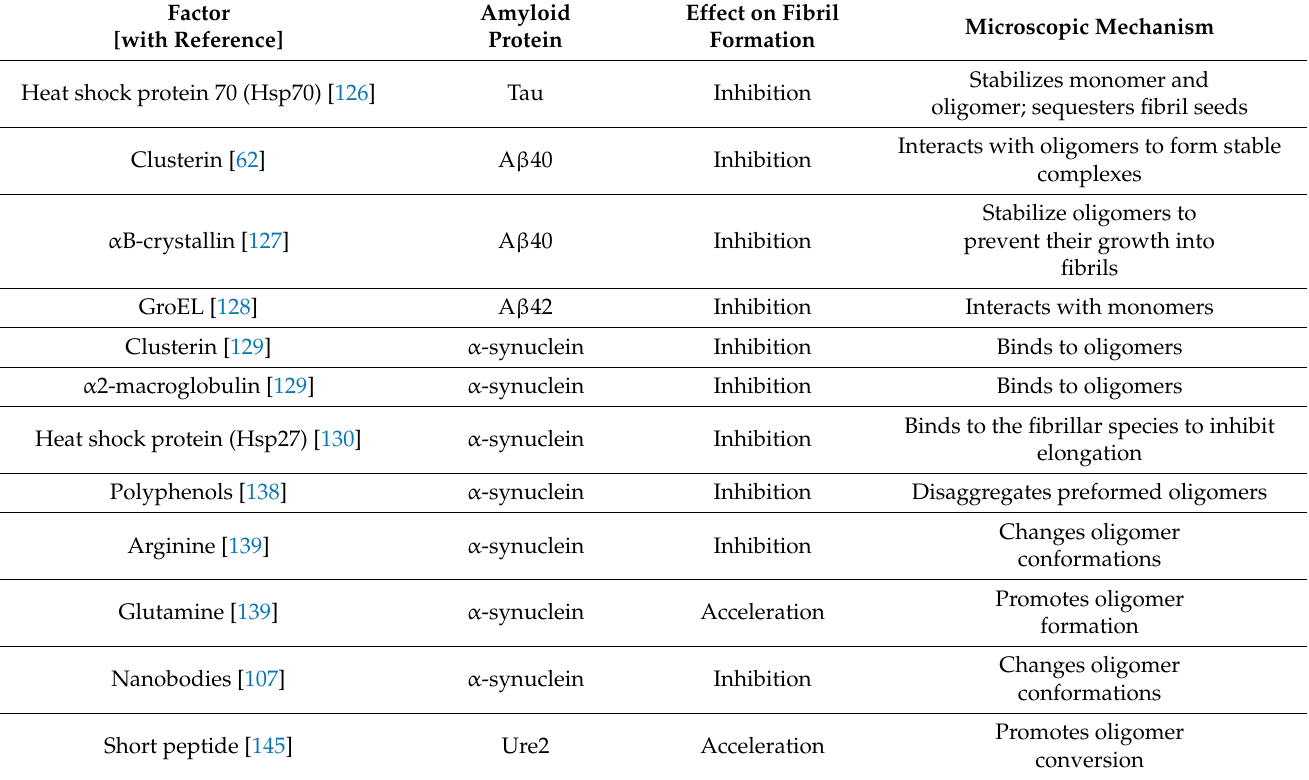
Table 1. The effects of different factors on amyloid aggregation revealed by single molecule study.